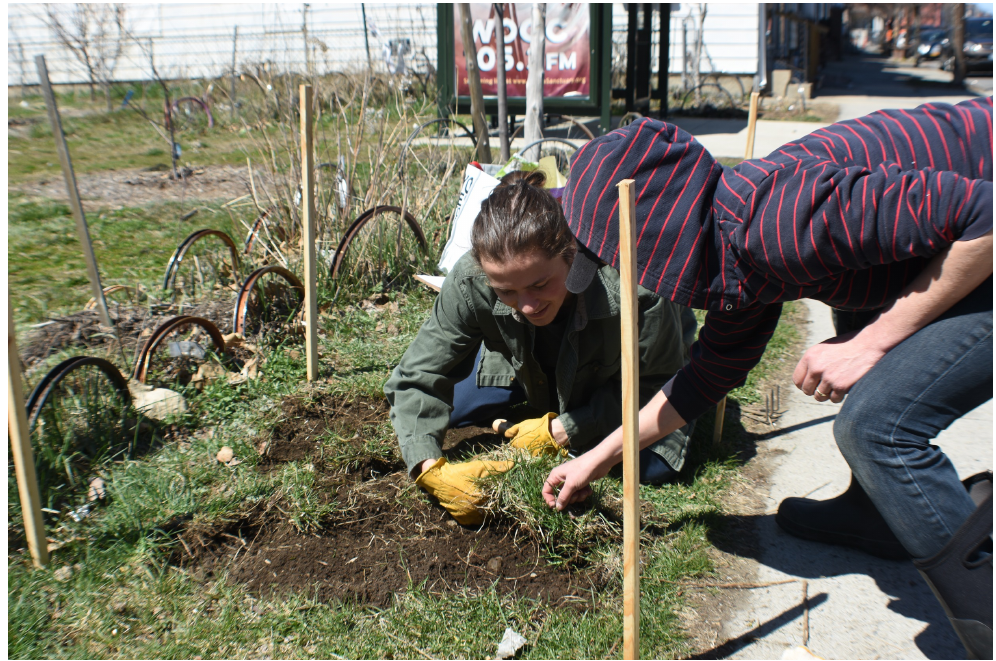
Figure 8: Workshop participants establish Lawn Lab plot #9 at the Sanctuary for Independent Media’s Freedom Square (6th Avenue and 101st Street), April 2019. The site pictured here has been lawn for at least forty years, according to documentation held in the Sanctuary’s archives. Photo courtesy of Lawn Lab participant Luke